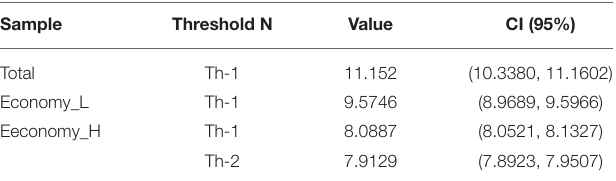
TABLE 5 | Test for threshold value.